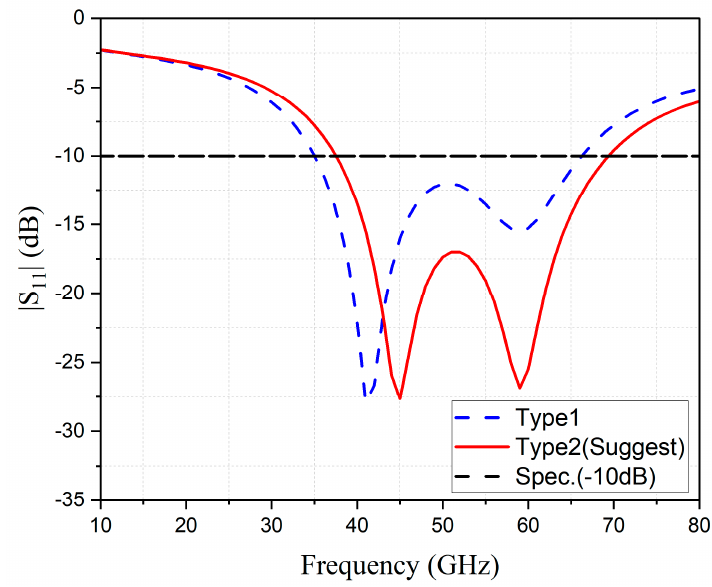
Figure 18. Reflection coefficient of probe GSG grounding with or without holes.